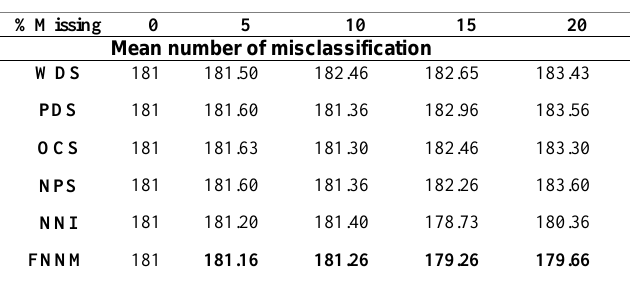
‎ Table 6. Mean number of misclassification on